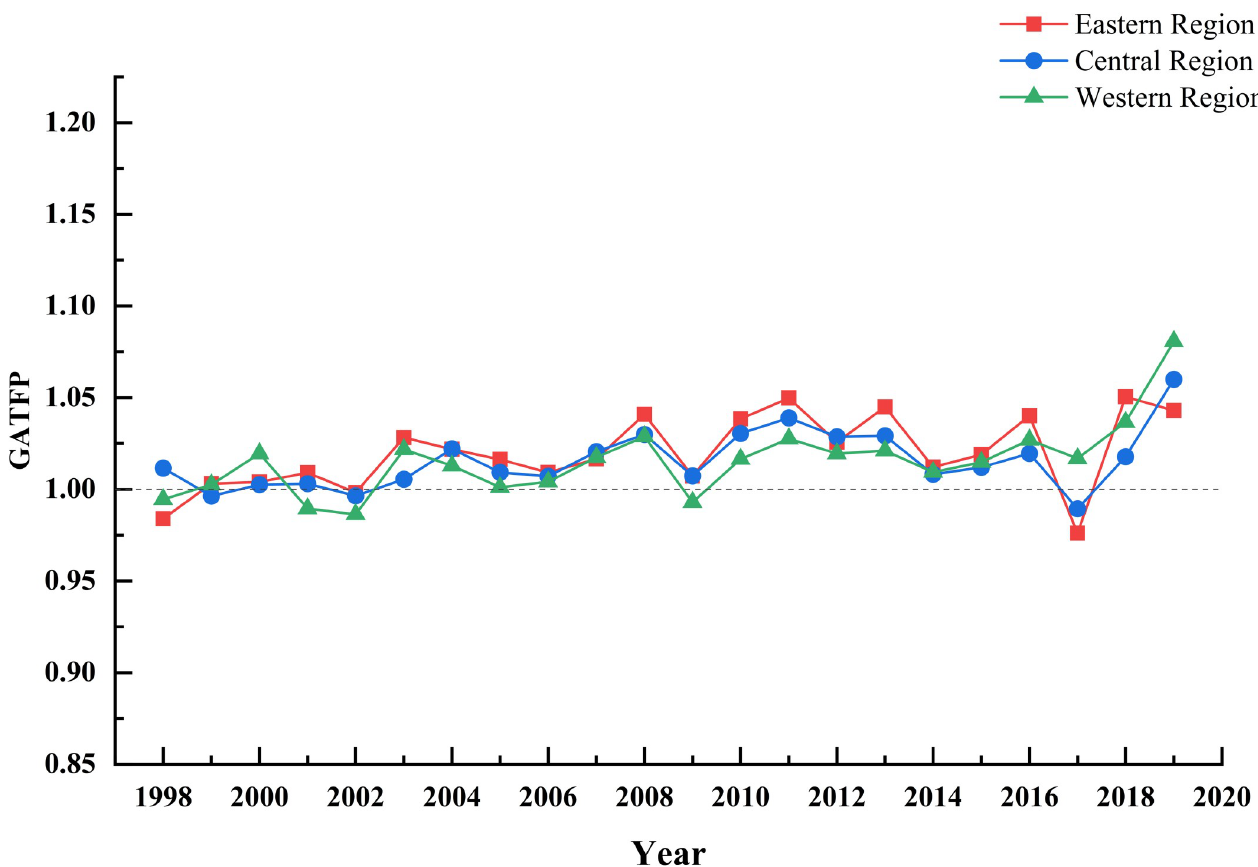
Fig 4. Changes of GATFP in the eastern, central and western regions from 1998 to